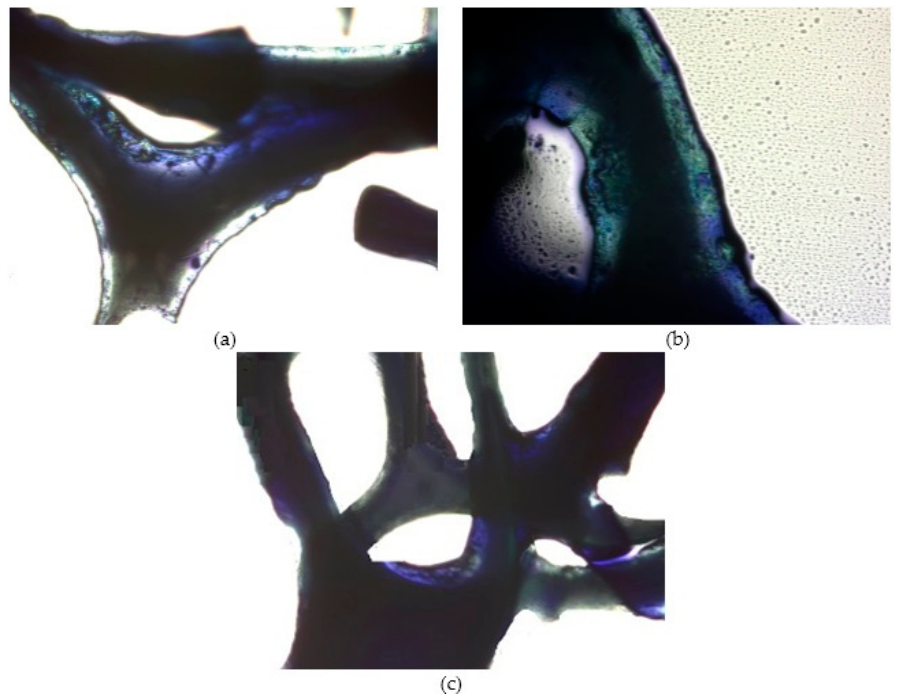
Figure 4. Optical microscope biofilm images. ( a ) The optical microscope images (10×) of a biofilm produced by C. albicans on polyurethane foam. ( b ) The optical microscope images (10×) of a biofilm produced by C. subhashii on polyurethane foam. ( c ) Control image: clean polyurethane